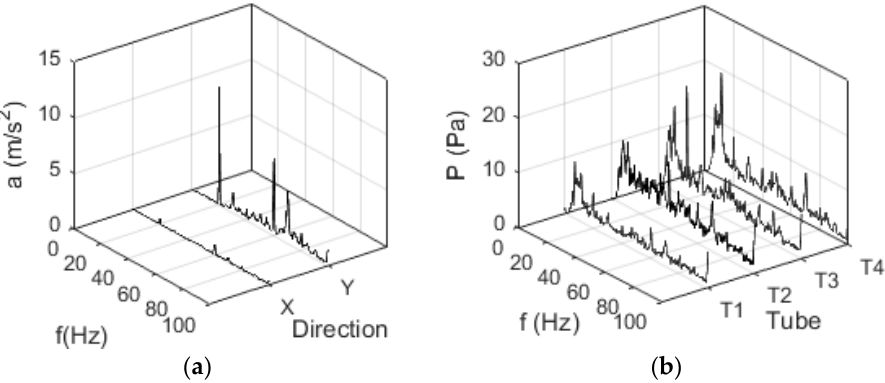
Figure 4. Typical spectra observed in accelerometers and pressure transducers for tubes at different positions in the stream channel. ( a ) Vibration amplitude in X and Y coordinates for de oscillating tube; ( b ) Pressure perturbations amplitude at different tubes in the